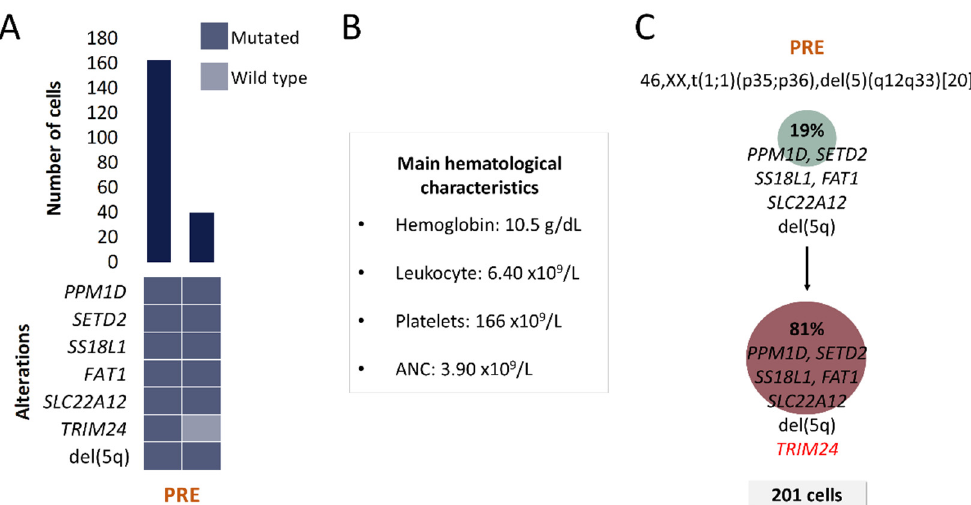
Figure 4. Clinical and molecular characteristics of patient P3. ( A ) Bar plot depicts the number of cells with a given genotype for each clone that was detected at the moment of pre-treatment (PRE). Heatmap below the bars indicates the genotype for each clone: dark blue and light blue are used to indicate the mutated or wild-type state, respectively. ( B ) Hematological characteristics such as hemoglobin (Hb), platelet count (Plt), leukocyte count (Leu) and absolute neutrophil count (ANC) are indicated for the analyzed time point. ( C ) Proposed clonal architecture, karyotype and number of analyzed cells for the analyzed time point are indicated. Color red distinguishes new acquired alterations in the secondary clone.